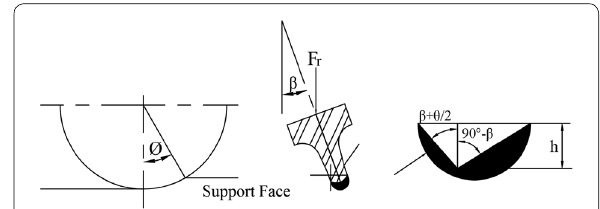
Figure 10 Contact area Figure 11 Area between dense core and rock of gauge